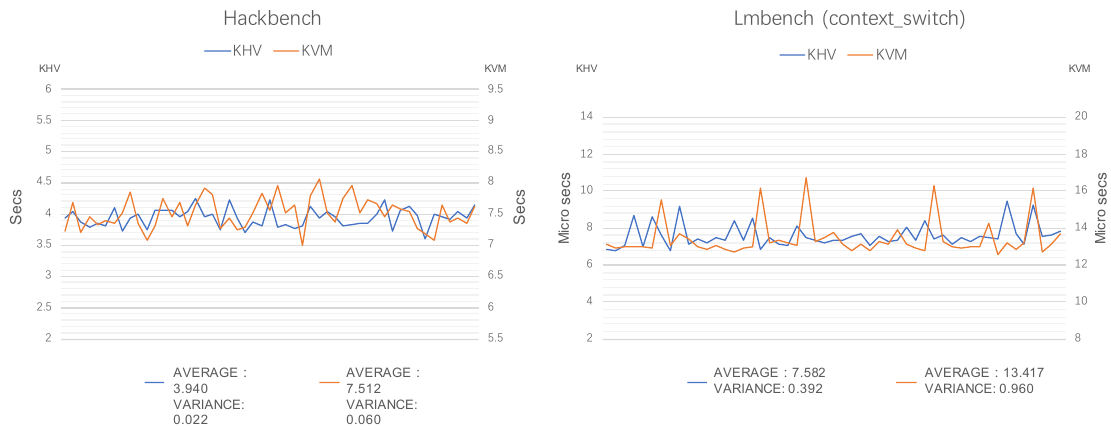
Figure 13. Context switch performance fluctuation graph.